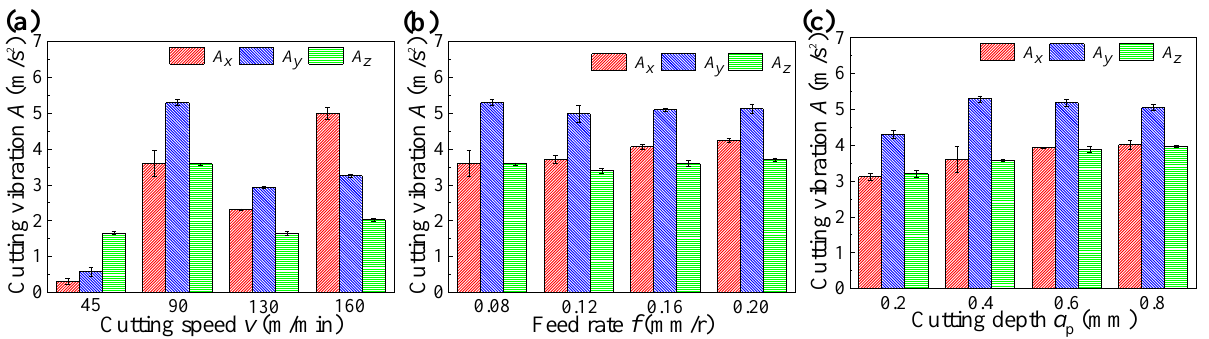
Figure 5. Cutting vibrations obtained under different cutting parameters: ( a ) cutting speed, ( b ) feed rate, and ( c ) cutting depth.